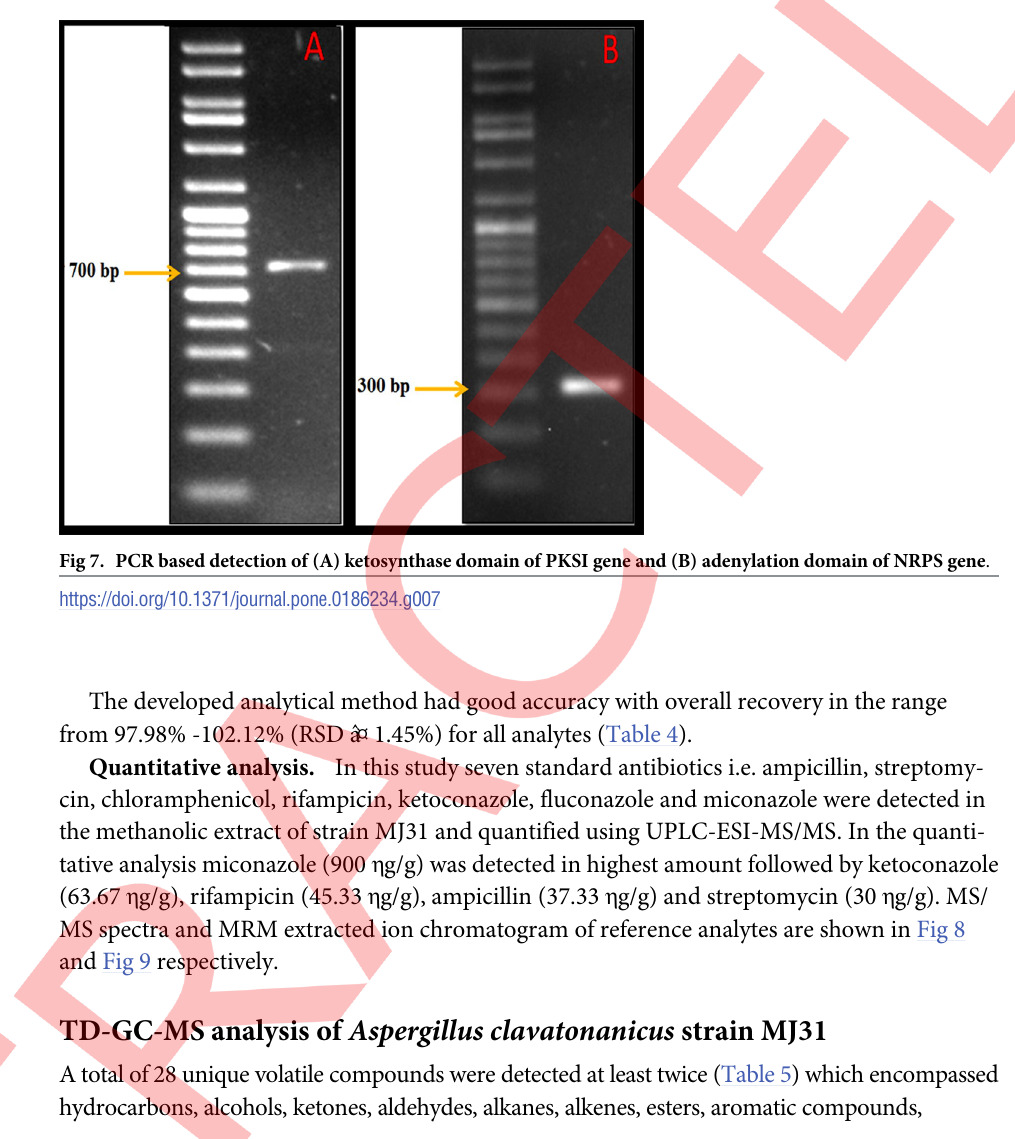
Table 4. Validation parameters of UPLC-MRM method for quantitative analysis of standard antibiotics and MJ31 crude extract. Analytes Regression